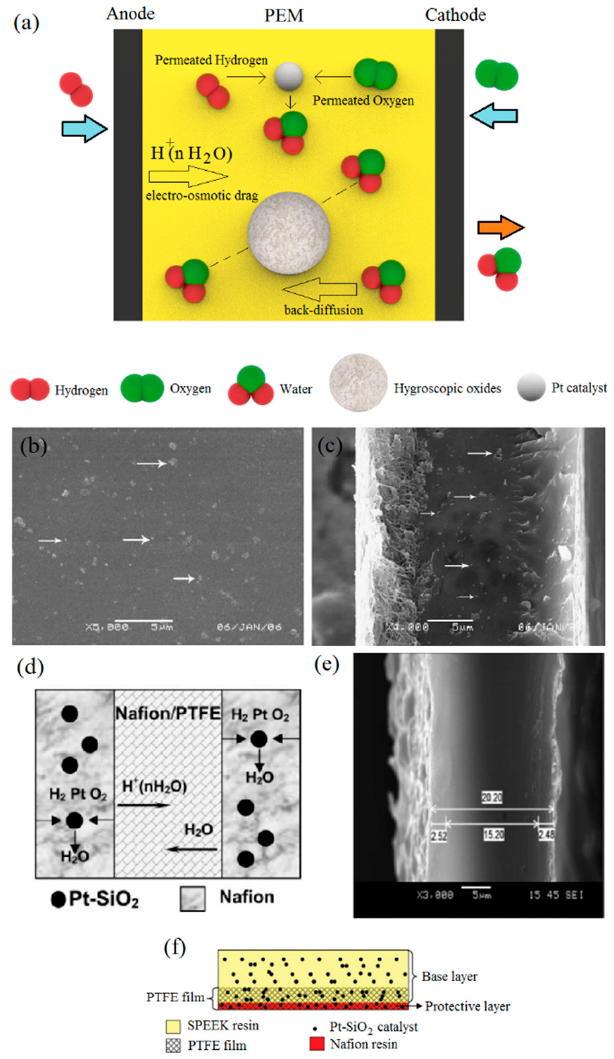
Figure 2. ( a ) Basic concept of self-humidifying PEMs endowed with hygroscopic oxides and Pt catalyst; ( b ) surface and ( c ) cross-section of Pt–SiO 2 / Nafion / PTFE (polytetrafluoroethylene) membranes (reprinted with permission from [50]); ( d ) schematic and ( e ) SEM image of ultra-thin PEM with Nafion / PTFE as a central layer and Pt–SiO 2 / Nafion as side layers (reprinted with permission from [51]); ( f ) schematic representation of Pt–SiO 2 / SPEEK / PTFE / Nafion / Pt–SiO 2 self-humidifying PEM (reprinted with permission from [52]).